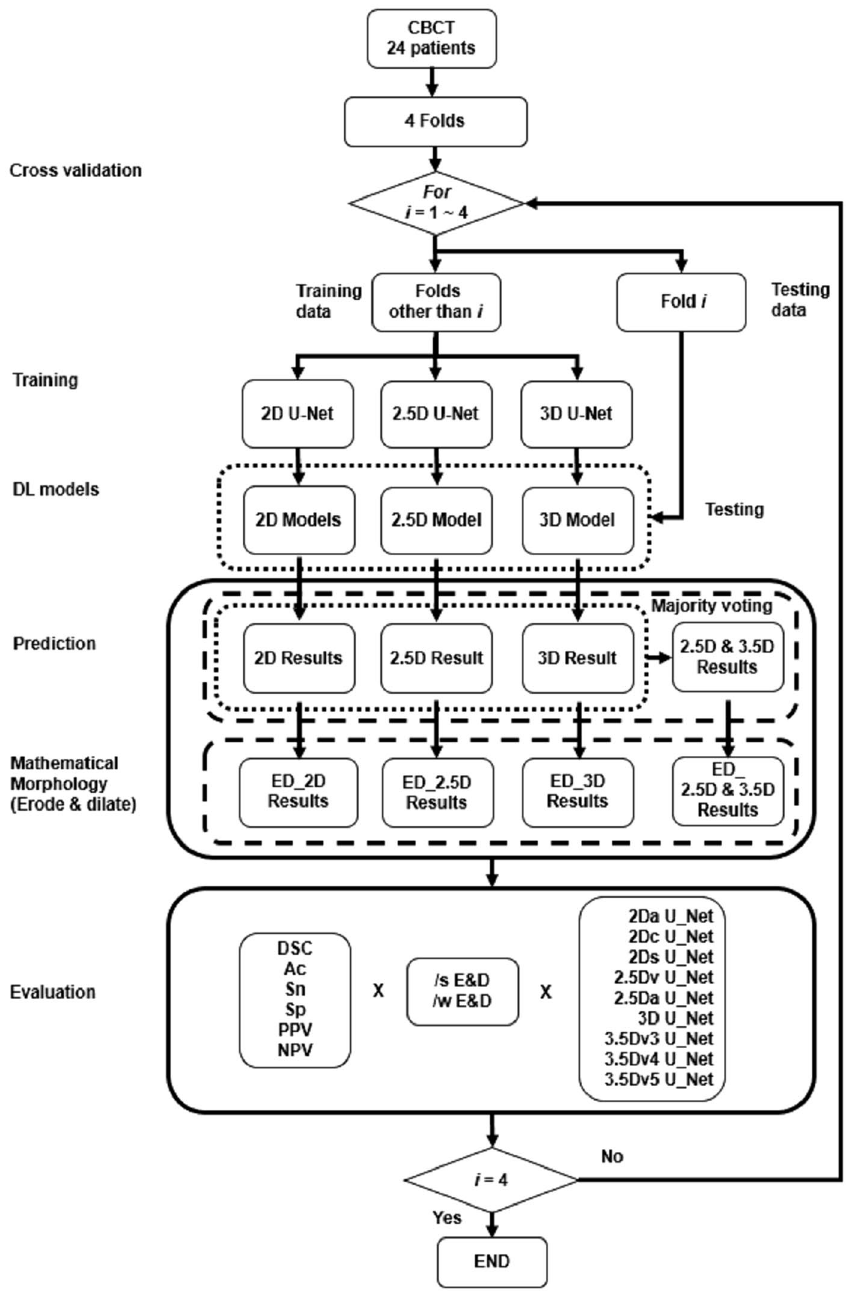
Figure 3. Flowchart of U-Nets in automatic segmentation of teeth using fourfold cross